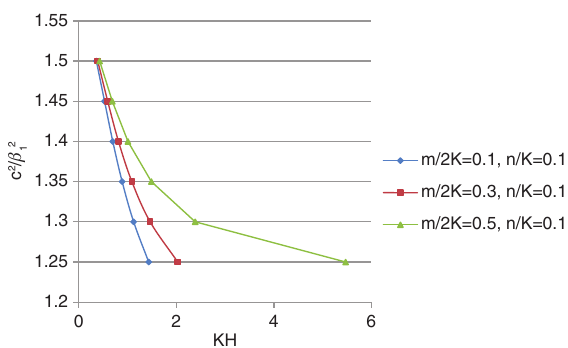
) 2 Figure 3: Variation of the dimensionless phase velocity (c/ β 1 against the dimensionless wave number KH, demonstrating the influence of non-homogeneity associated with the